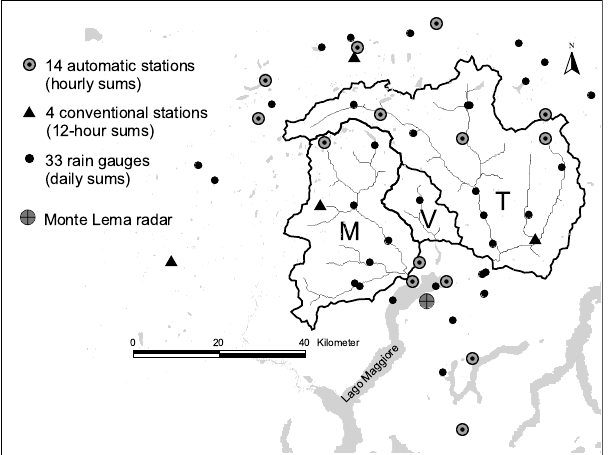
Fig. 3. Locations of meteorological stations in and around the Ticino-Verzasca-Maggia (T, V, M) watershed applied in hydrologic simulations and the Swiss Monte Lema radar. The precipitation ob- servation frequency is indicated.